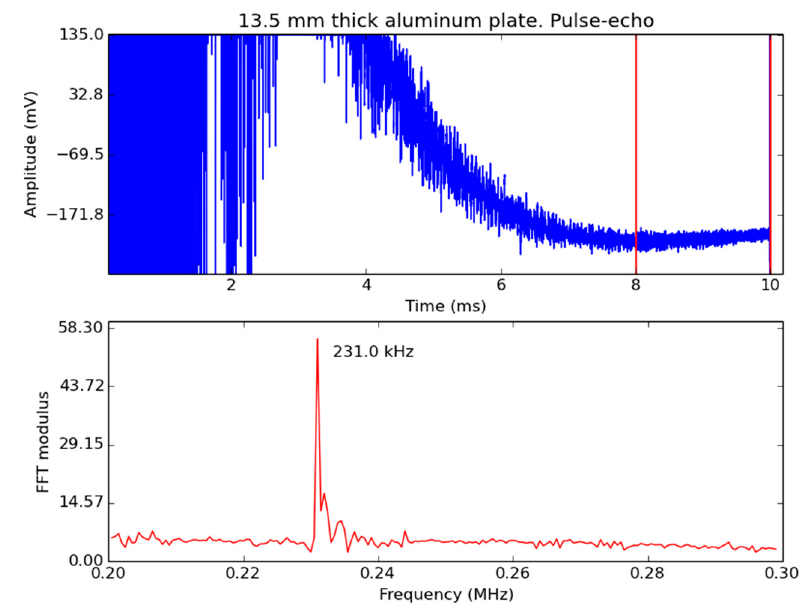
Figure 10. Pulse-echo; 13.5 mm-thick aluminum plate: signal in the time domain ( top ) and FFT modulus of the signal within the indicated window ( bottom ).